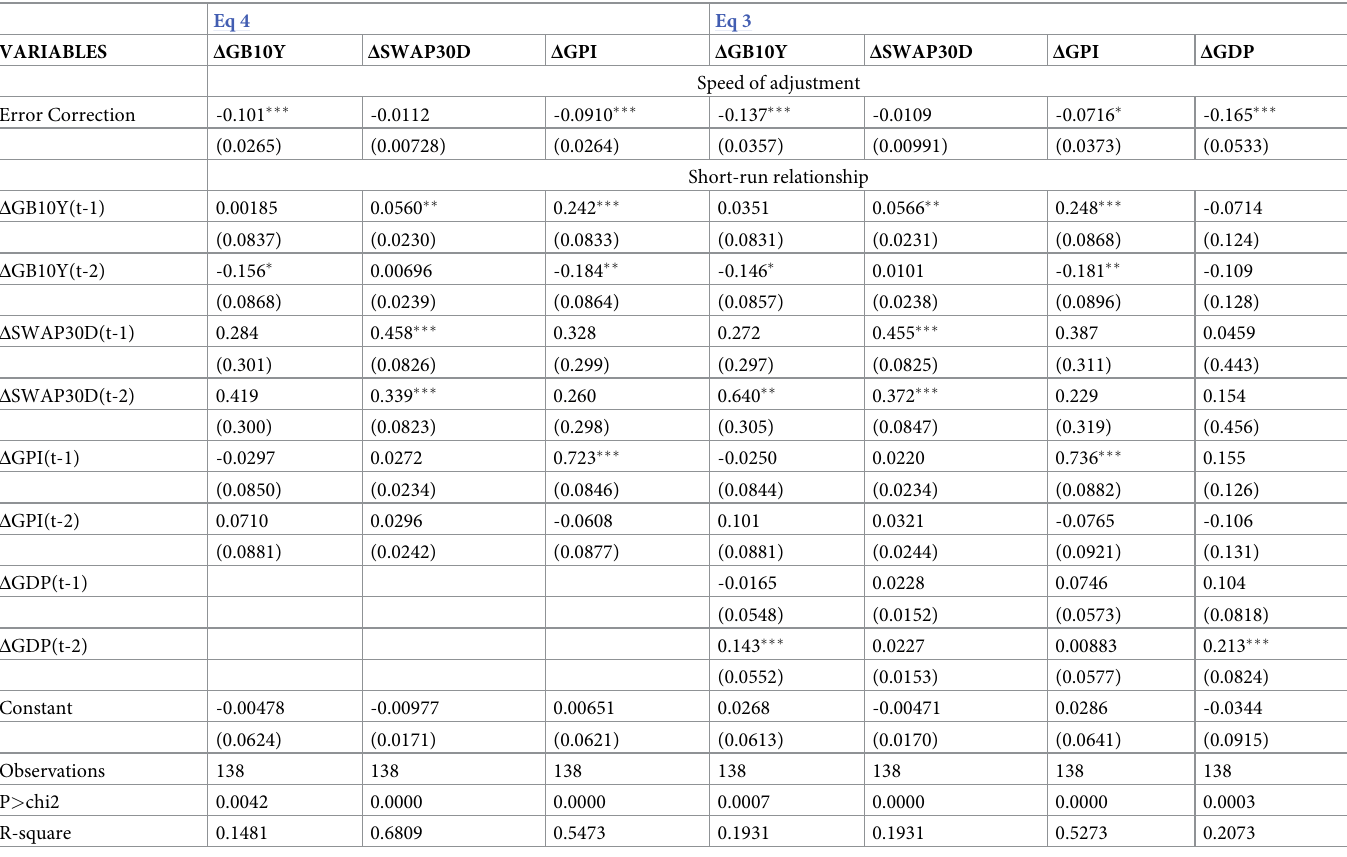
Table 5. Speed of adjustment and short-run relationship from VECM for Eq 3 and Eq